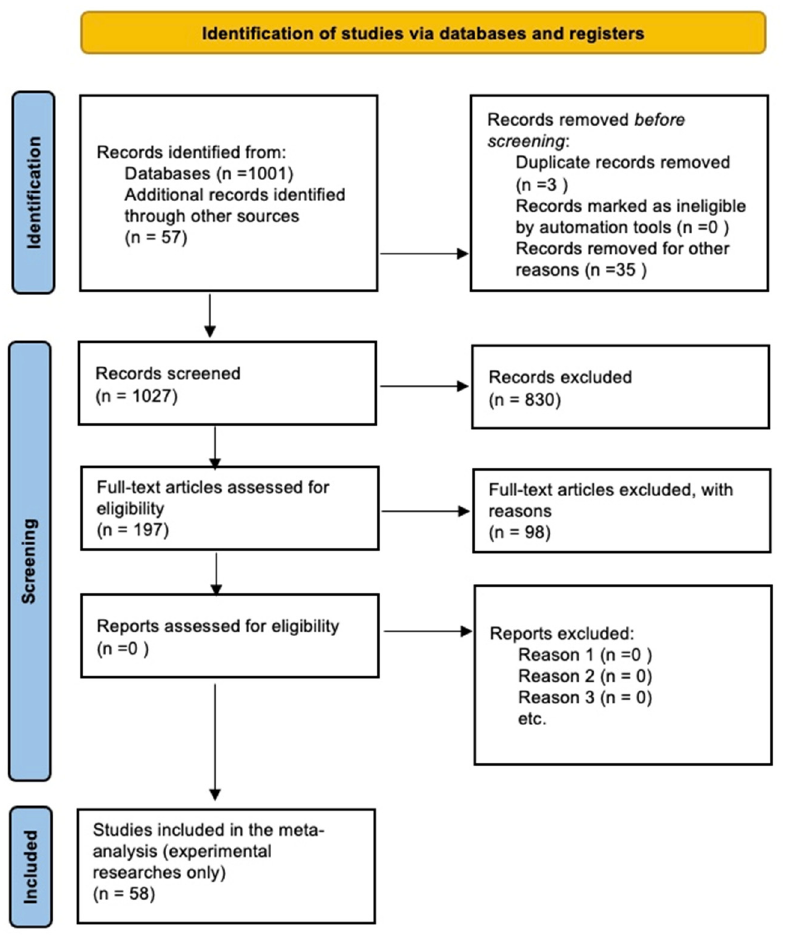
Figure 1. The flowchart of stages we followed in the review, based on the PRISMA approach to a systematic review [39].